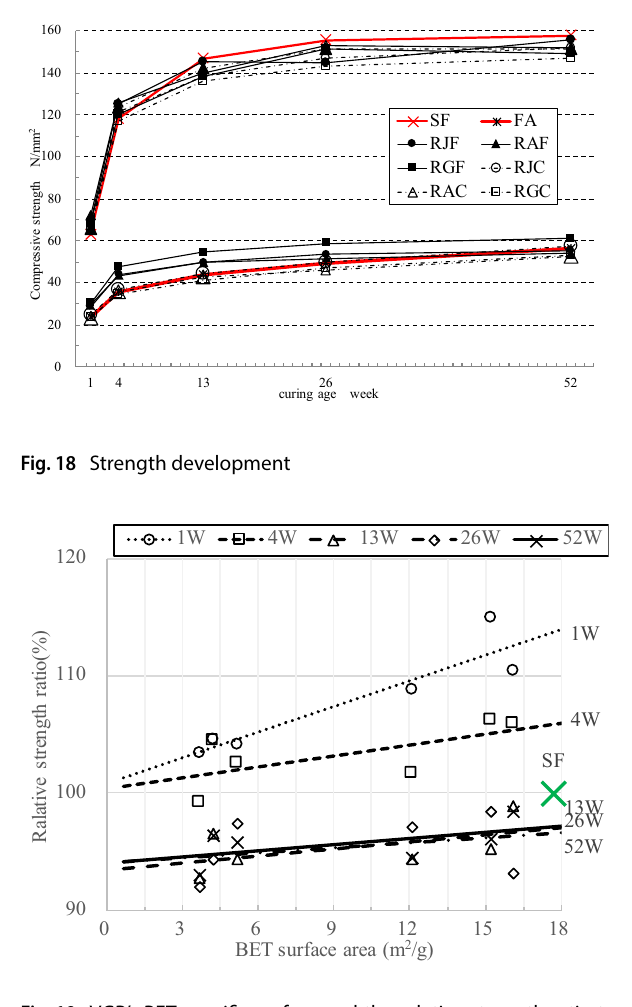
Fig. 19 VGP’s BET specific surface and the relative strength ratio to SF at W/B = 0.2